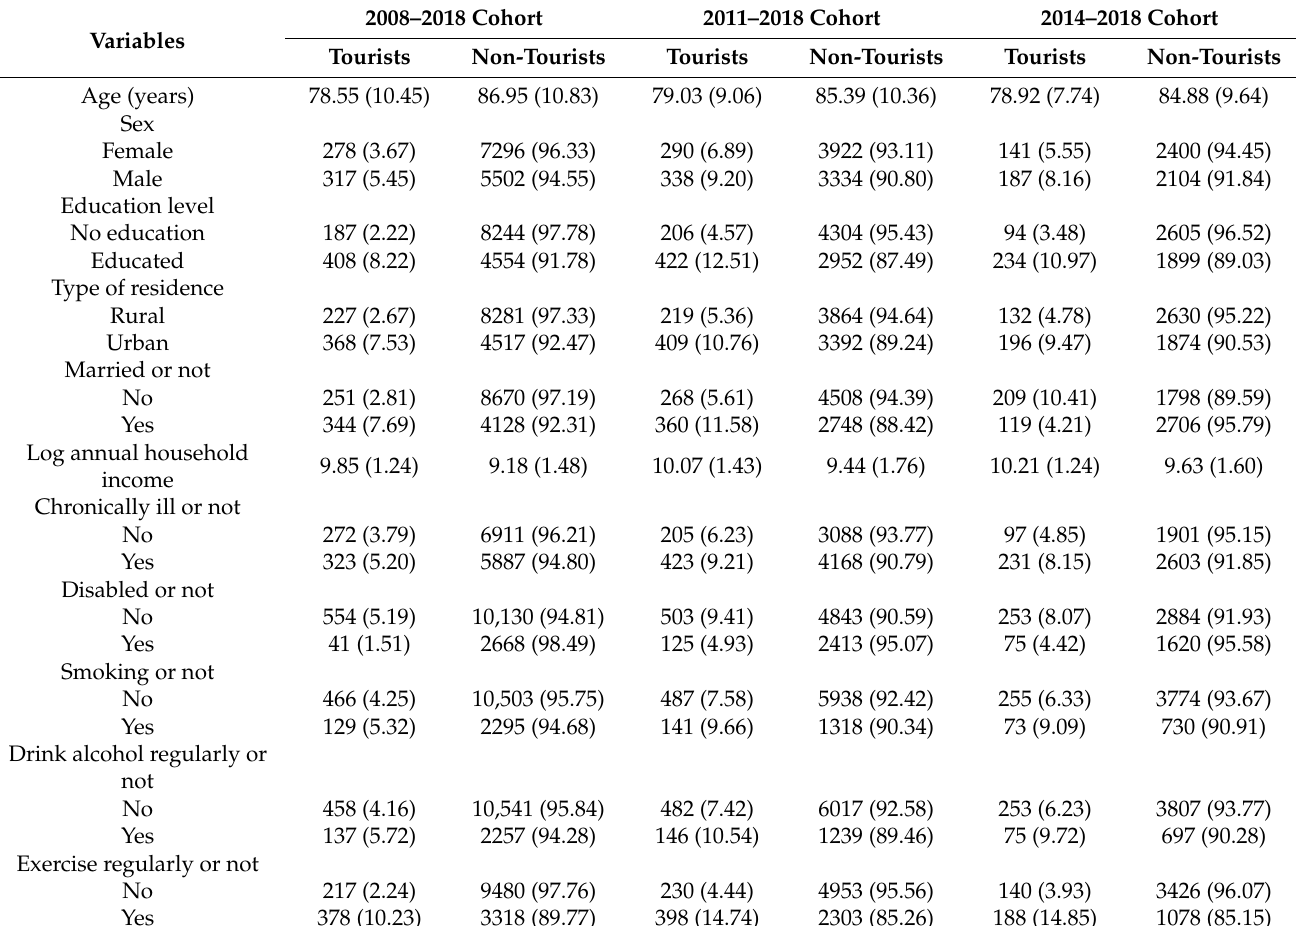
Table 1. Descriptive statistical